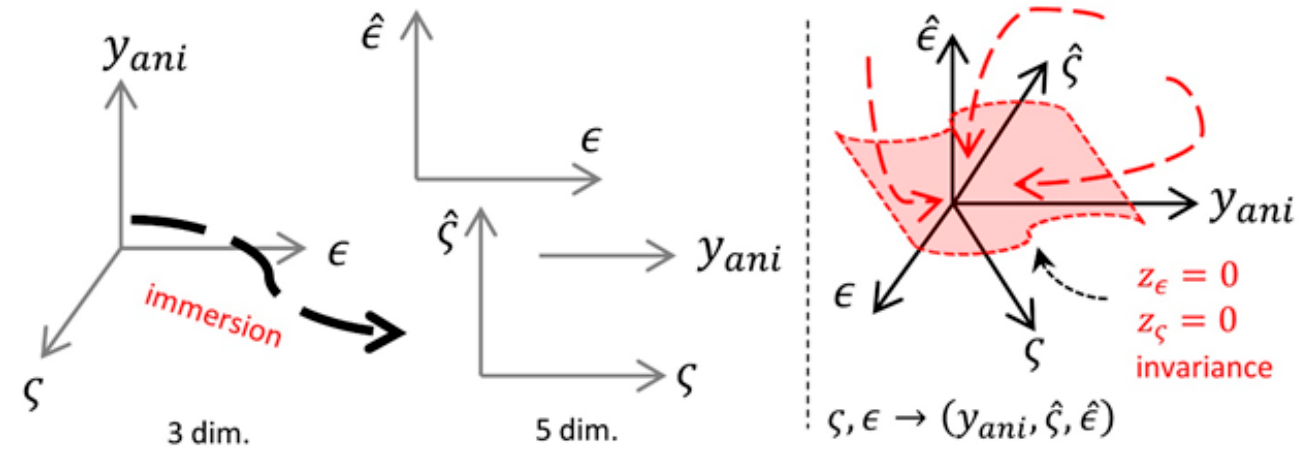
Figure 3. Immersion and Invariance application on analytical output noise ( (cid:1877) (cid:3028)(cid:3041)(cid:3036) ).